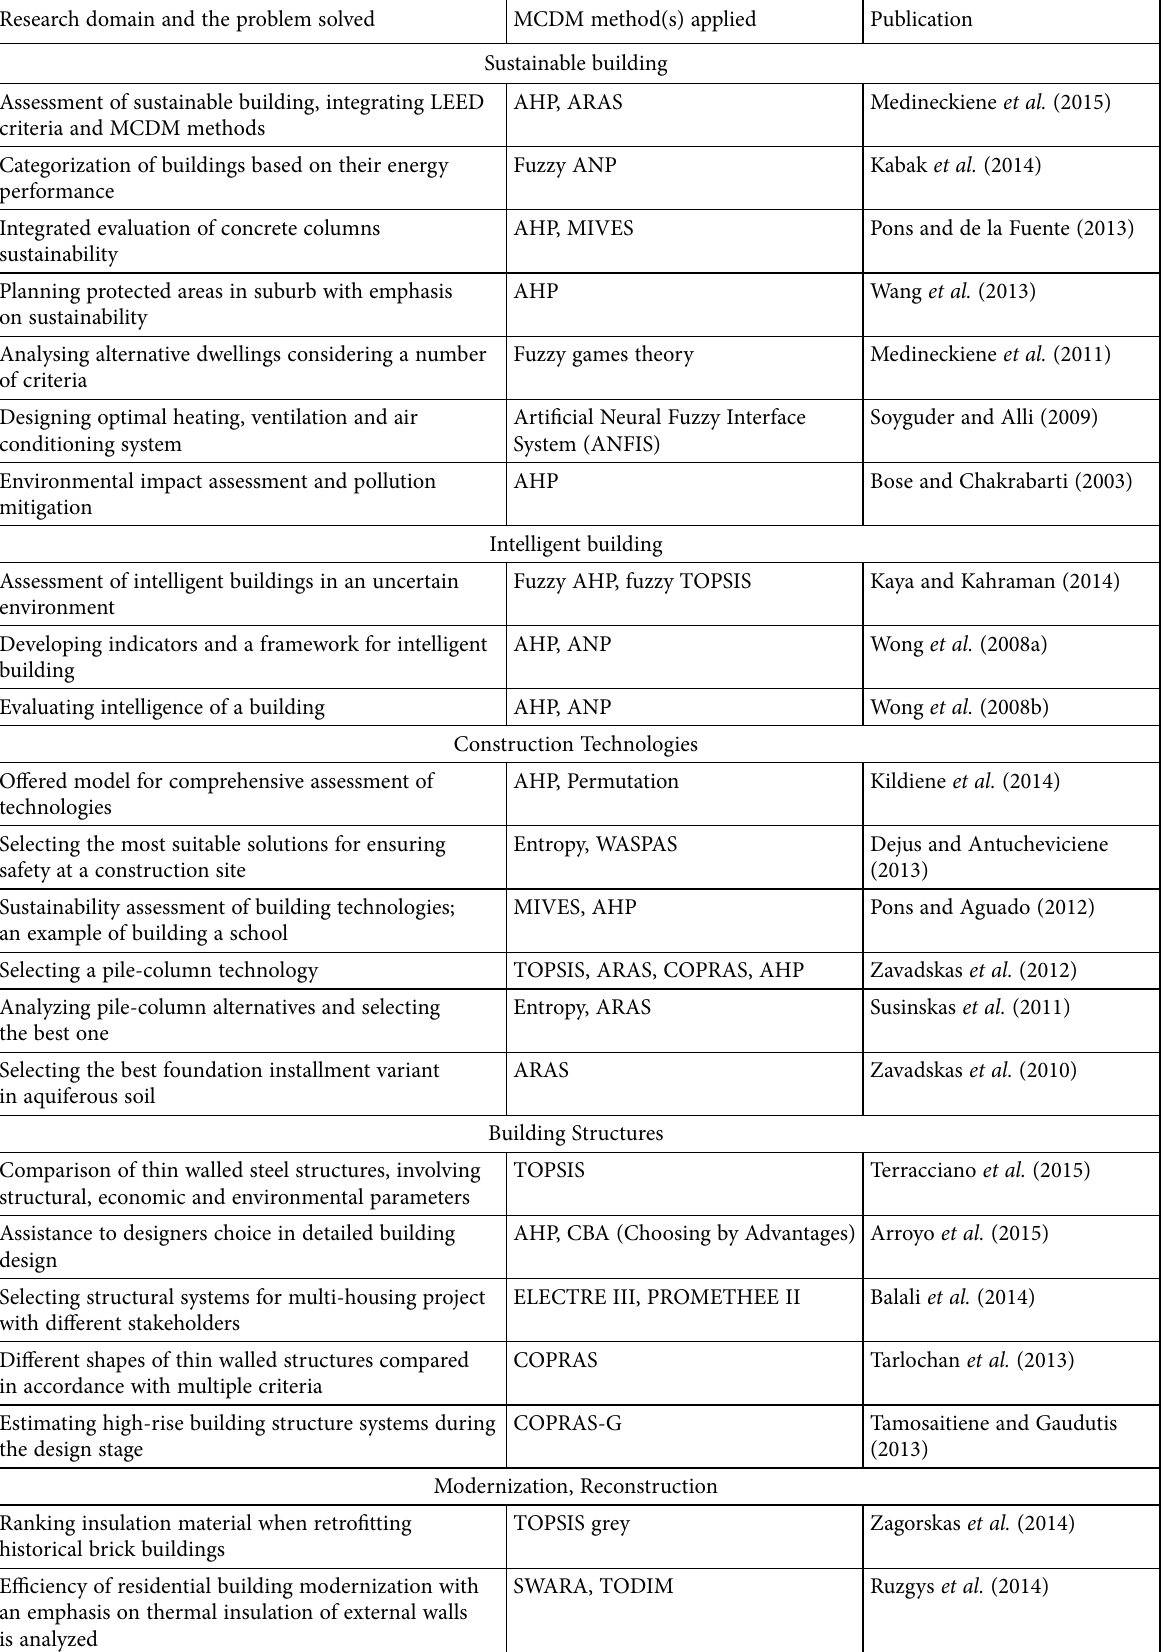
Table 1. MCDM applications by research domains in Construction Building Technology research